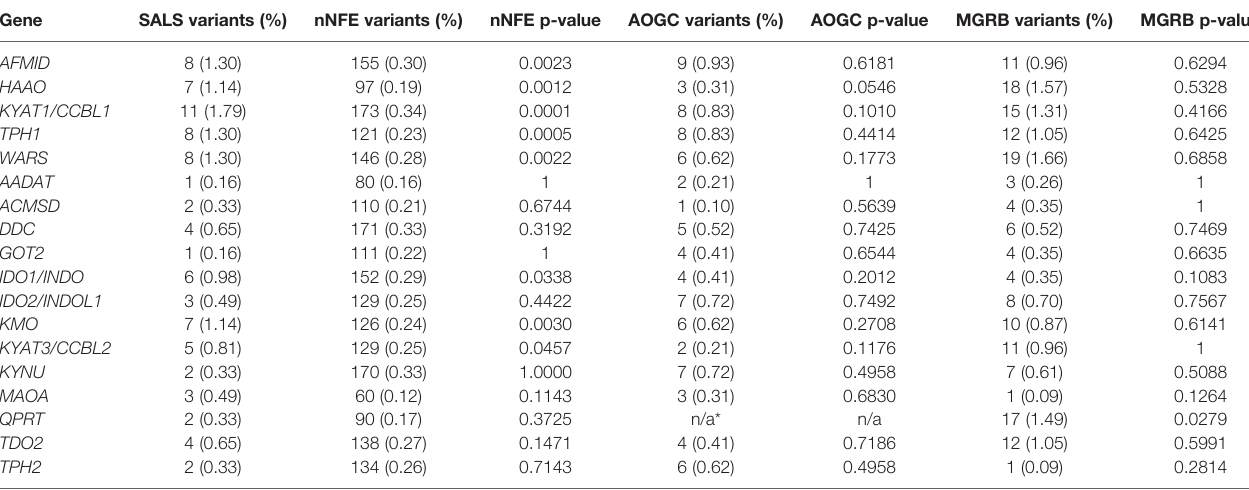
*Insuf fi cient data available to calculate gene burden.